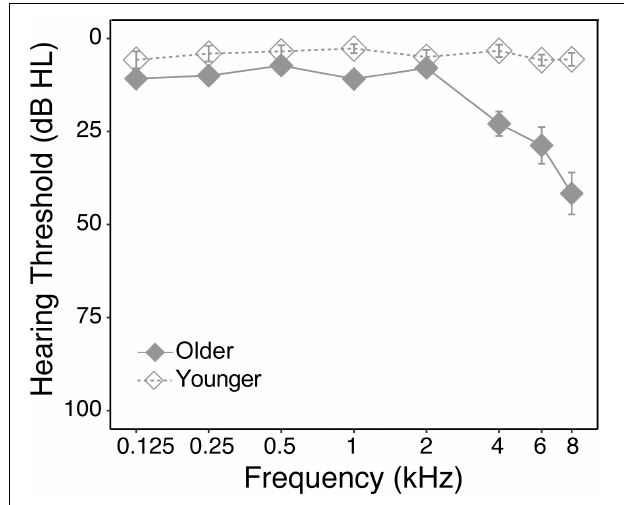
FIGURE 1 | Average pure-tone audiograms for each group. Hearing thresholds (dB HL) were plotted as function of pure-tone frequencies. Solid and empty diamonds represent older and younger groups,